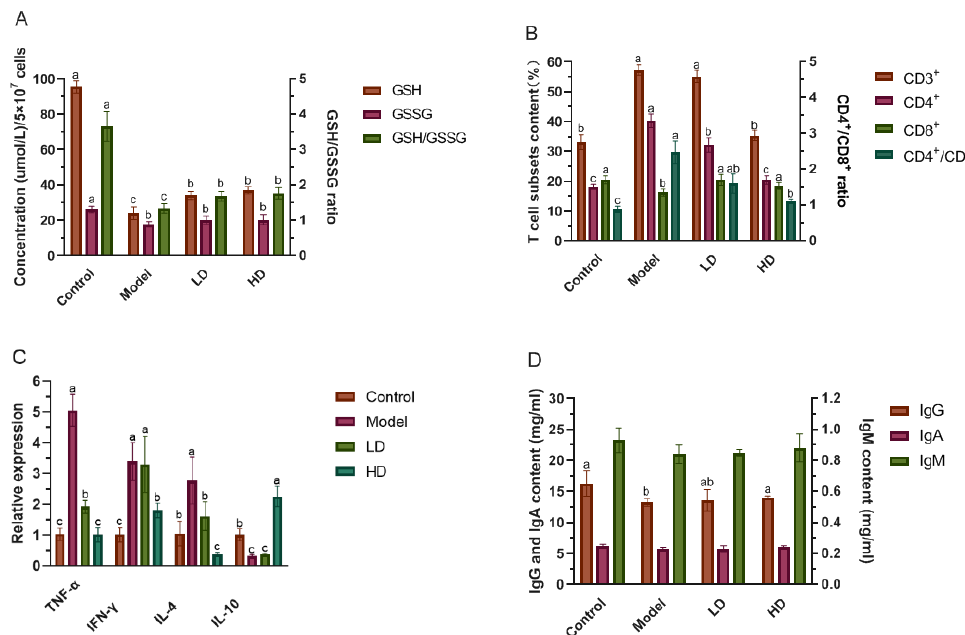
Figure 4. Effect of FBPE on immune response in splenocytes, colon and serum of DSS-induced colitis. GSH, GSSG content and GSH/GSSG ratio in splenocytes ( A ), T cell subsets content in splenocytes ( B ), inflammatory cytokines mRNA levels in colon ( C ), immunoglobulin (IgG, IgA and IgM) content in serum ( D ). Different lower-case letters correspond to a significant difference at p <